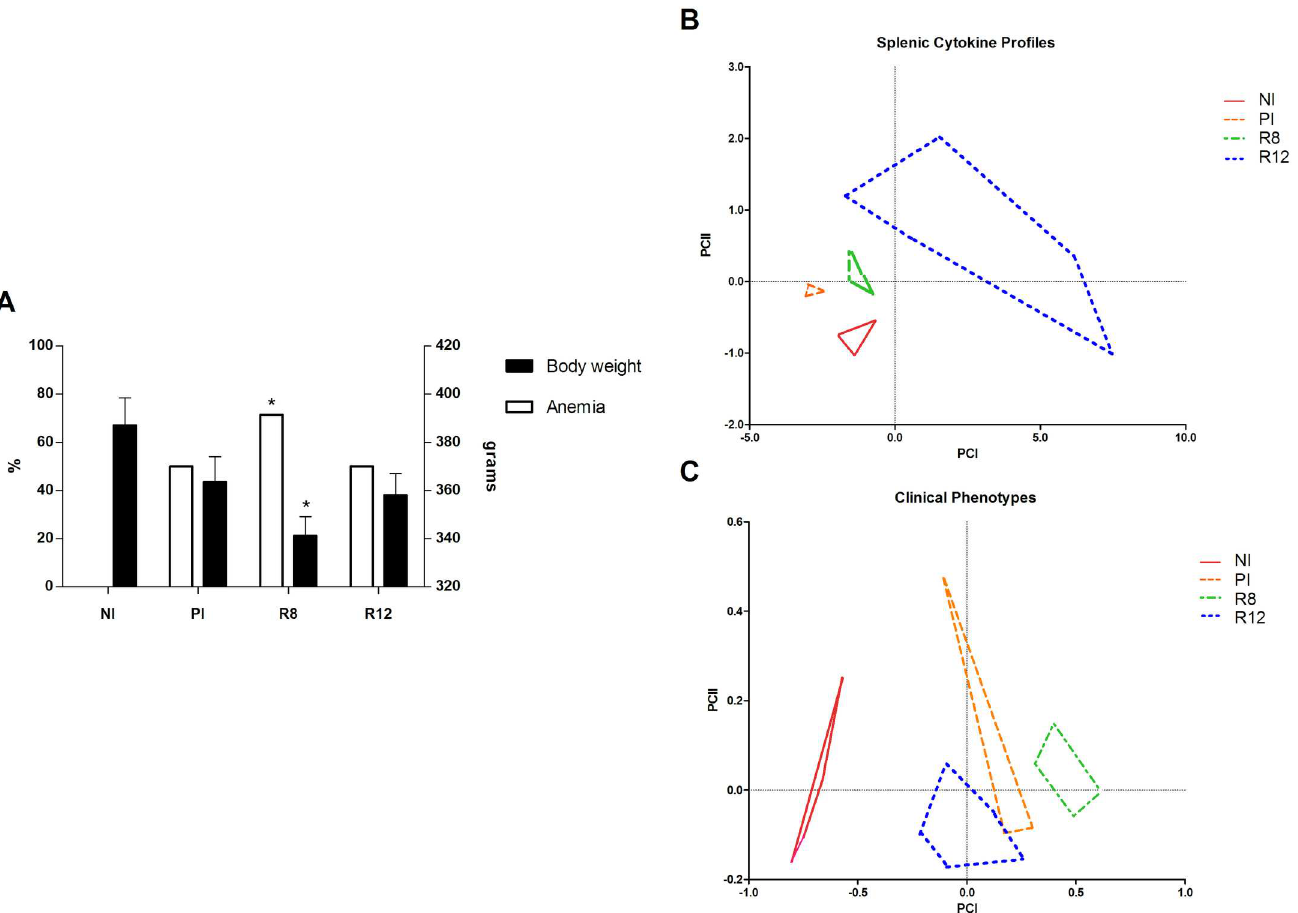
Fig 8. Pathogenicity and systemiccytokine expression levels. A) Effect of Fasciola hepatica reinfection on anemia and rat body weight. B) Factor map corresponding to splenic cytokine profiles from experimentally infected Wistar rats including fluke burden. Samples are projectedonto the first (PCI, 86%) and second (PCII, 5%) principalcomponents.Each group is represented by its perimeter. C) Factor map corresponding to clinical phenotypes from experimentally infected Wistar rats. Clinicalphenotypes are definedby fluke burden, rat body weight, RBC, HGB, HCT, MCV, MCH, MCHC, RDW-SD, RWD-CV and EOS% detected in each rat group (NI, PI, R8 and R12). Samplesare projectedonto the first (PCI: 84%) and second (PCII: 11%) principalcomponents. Each group is representedby its perimeter. Group NI: non-infected controls; Group PI: rats received a single infectiondose; Group R8: infected and reinfected rats at 8 weeks after primary infection; Group R12: infected and reinfected rats at 12 weeks after primary infection. Bars represent mean ± SE values. * Statistically significantdifferences (rat body weight: Mann-Whitney non-parametric test; anemia: chi-square test; P <